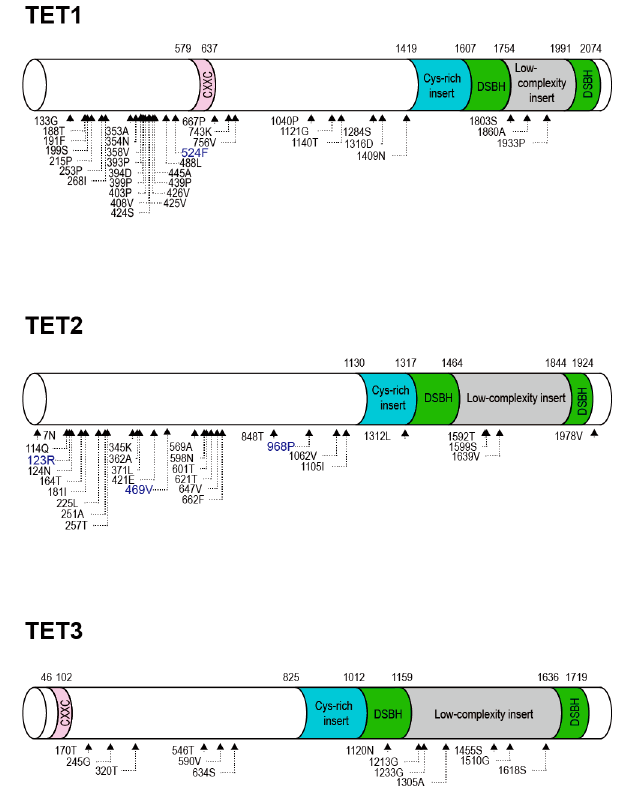
Figure 1. Structural representation of positively selected codon sites in mammalian TET family genes. Based on the human TET gene structure, domain diagrams of TET1, TET2 and TET3 are shown with CXXC, Cys-rich insert, DSBH and low-complexity insert domains. The corresponding domain boundaries are shown with the amino acid number above the diagram. The triangles at the bottom represent sites of positive selection identified by at least three of the six analysis methods used. Amino acid sites detected by PAML using model M8 are highlighted in blue.